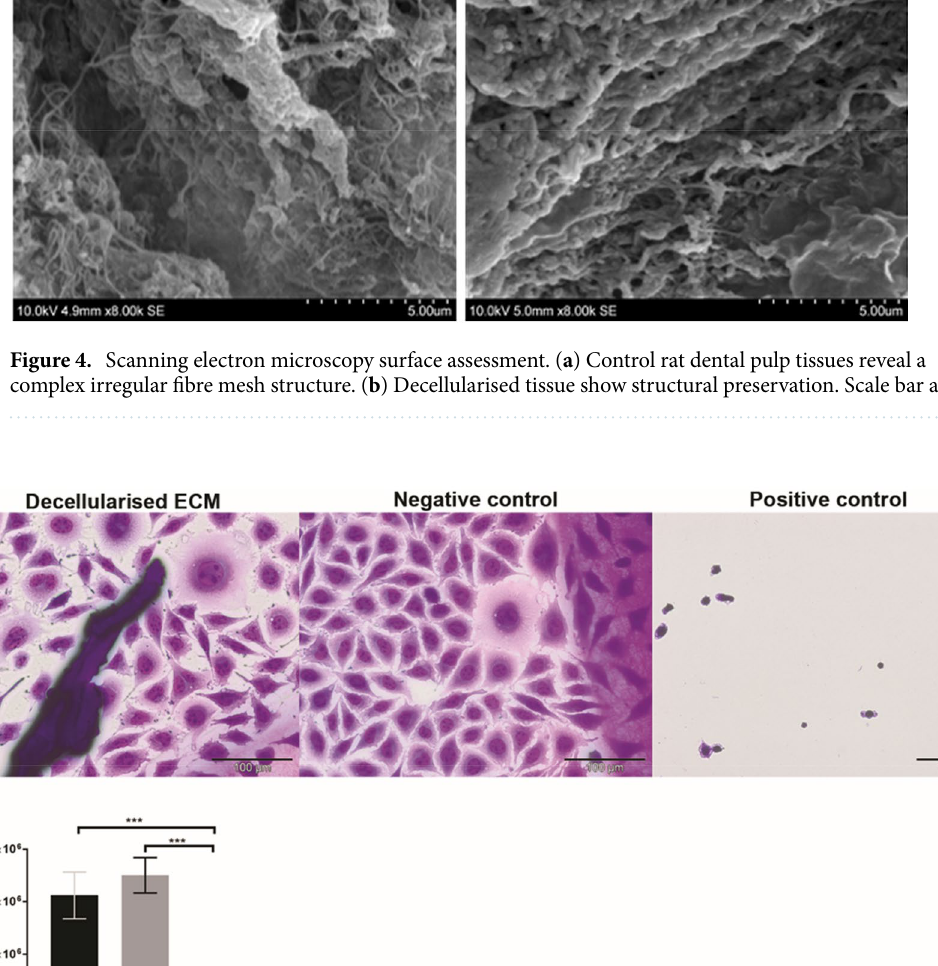
viable cells (stained green with Calcein-AM), of elongated morphology, repopulating the decellularized scaffolds with limited appearance of dead cells (stained red with ethidium homodimer) (Fig. 6). Histological assessment of human DPSCs cultured on decellularised pulp tissue. Serial sec- tions of the recellularised scaffolds were assessed with H&E staining to determine the ability of DPSCs to attach, migrate and differentiate within the decellularised scaffolds. Following 7 and 14 days culture, the DPSCs appeared elongated with a spindle-shaped morphology attached to the outer scaffold surface and between the collagen fibers. As time elapsed, there was an apparent change in the scaffold shape from a longitudinal (day 7) to a contracted circular shape (day 14; Fig. 6). sue. Antibody labelling was performed to assess the ability of the seeded DPSCs to express cytoskeleton